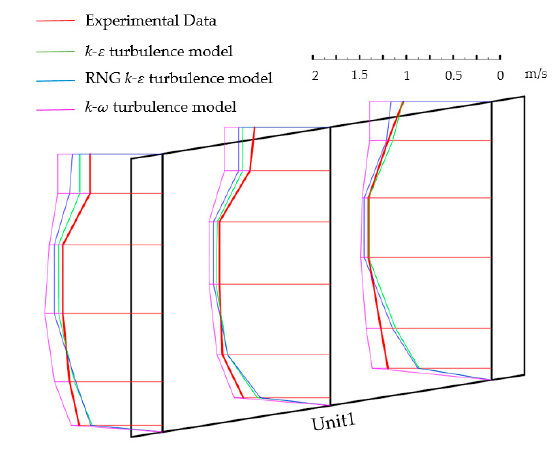
Figure 2. Velocity distribution under different turbulence models and experiments.